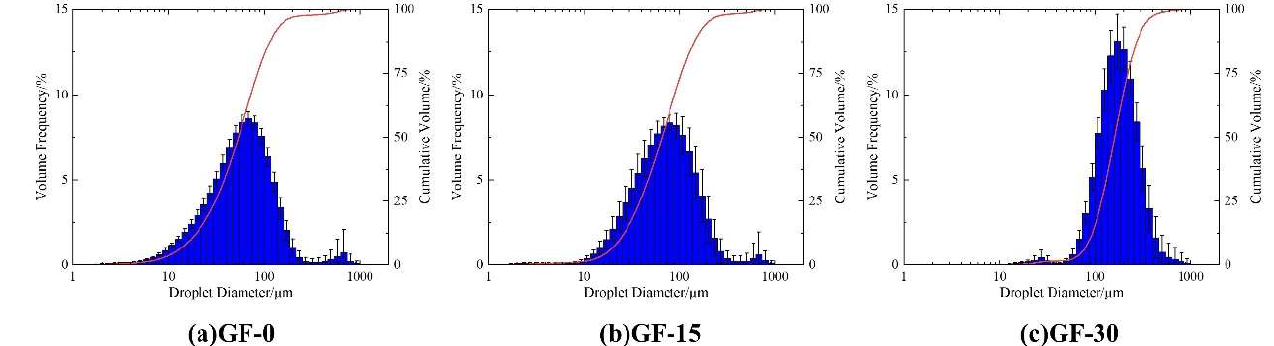
Figure 8. Droplet size distribution of different gelled fuels using swirl nozzles.